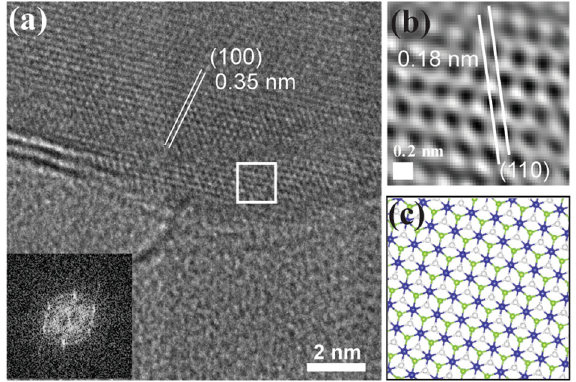
Fig. 4 Structural analysis of hexagonal-CoSe. a HR-TEM image of the basal-plane oriented h-CoSe. The inset shows the FFT pattern. b Filtered image of the area indicated with a square in a . c Atomic model for h-CoSe with Co (blue) and Se (green: top layer of Se and white: bottom layer of Se). The scale bar in panel a represents 2 nm, the scale bar in panel b represents 0.2